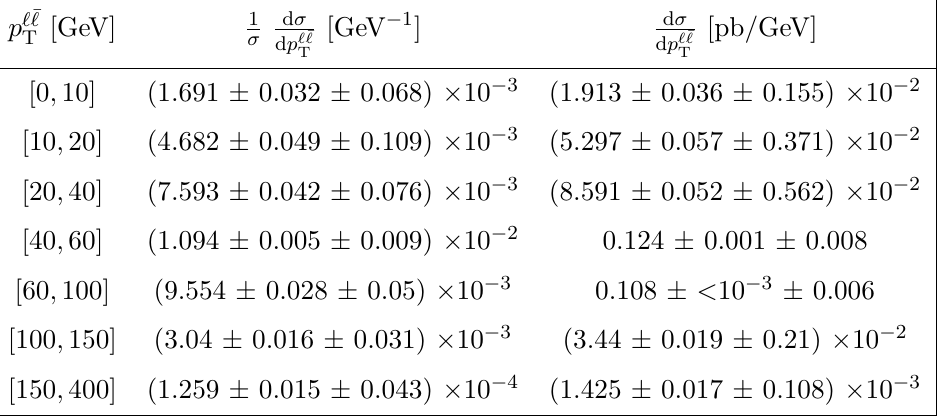
Table 37 . The measured di(cid:11)erential cross section and bin boundaries for each bin of the normalized and absolute measurements of the tt di(cid:11)erential cross section at particle level in the (cid:12)ducial phase space as a function of p ‘ (cid:22) ‘ are tabulated. T